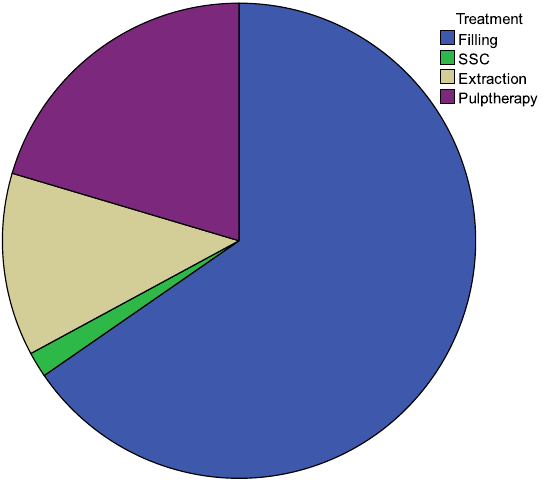
Figure 3. Distribution of treatment